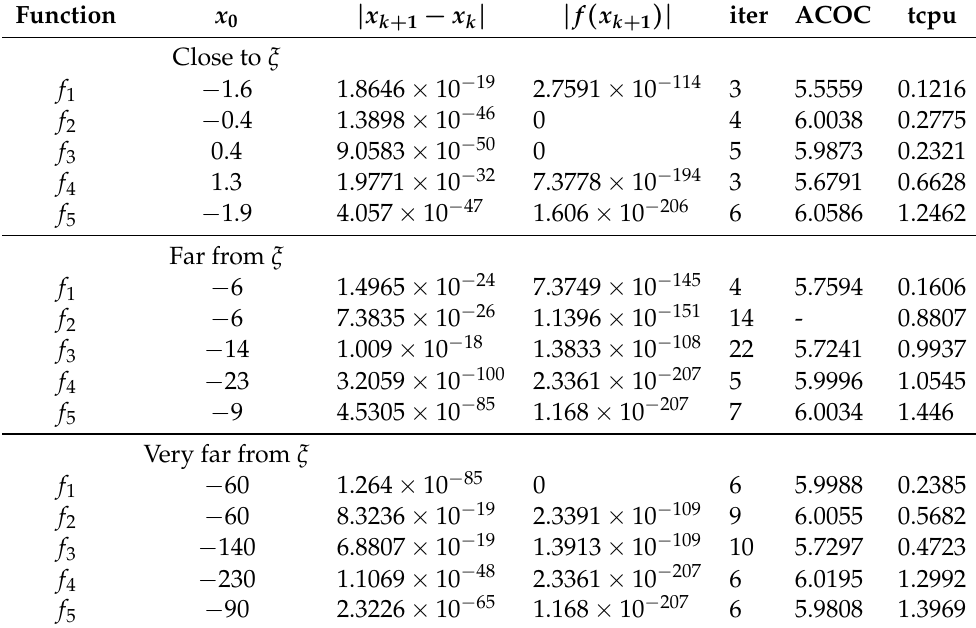
Table 4. Numerical performance of CMT ( − 1) method in nonlinear equations.